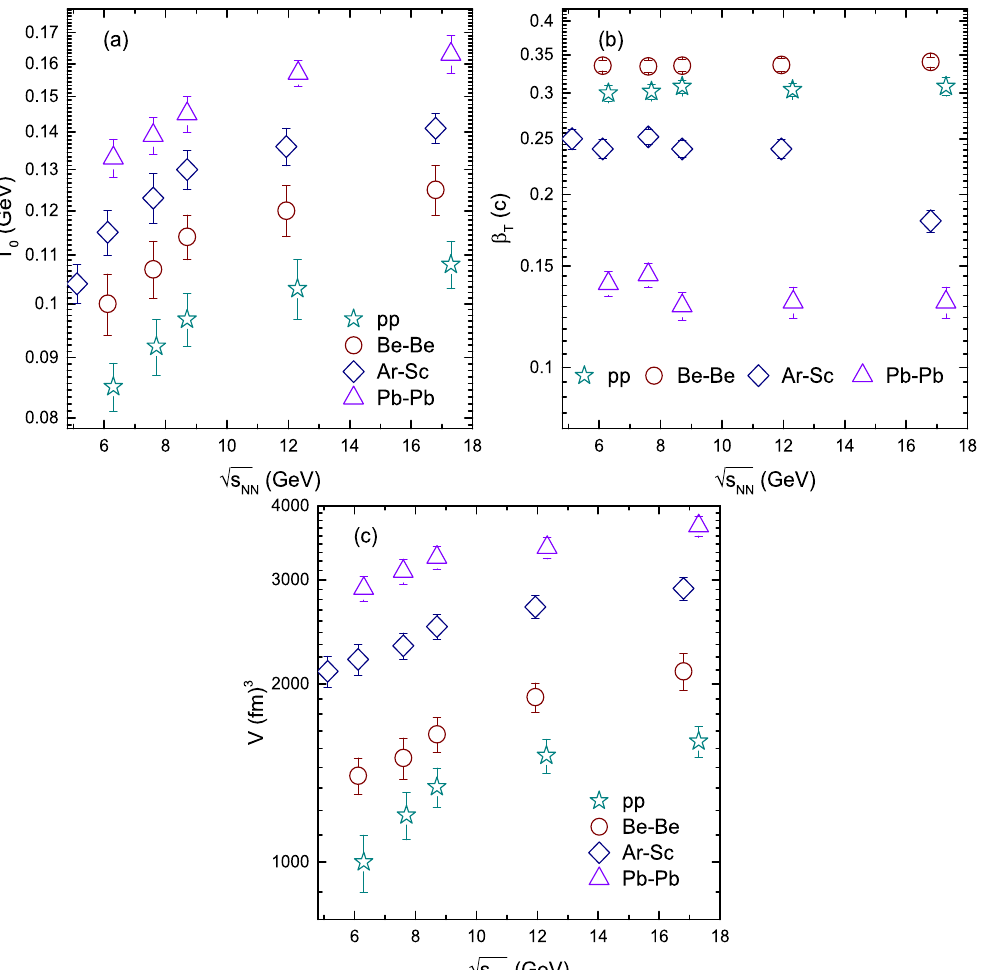
Figure 2. Dependence of ( a ) kinetic freeze-out temperature, ( b ) transverse flow velocity, and ( c ) kinetic freeze-out volume on collision energy and collision